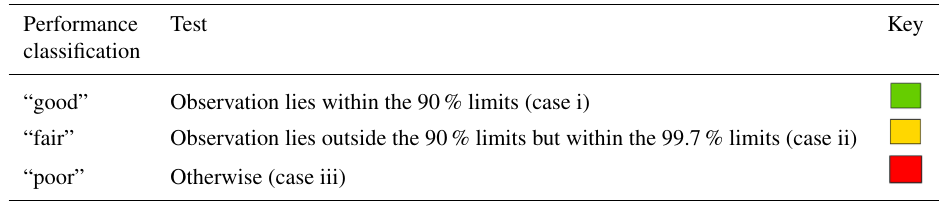
Table 2. CASE performance classification criteria. Adapted from Bennett et al.